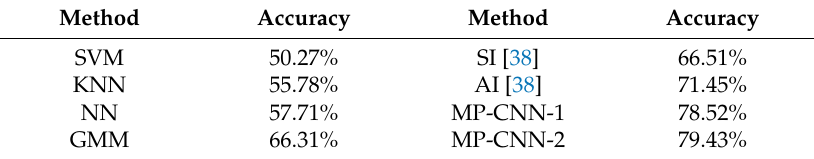
Table 3. Classification accuracy of the WHARF dataset using different methods.